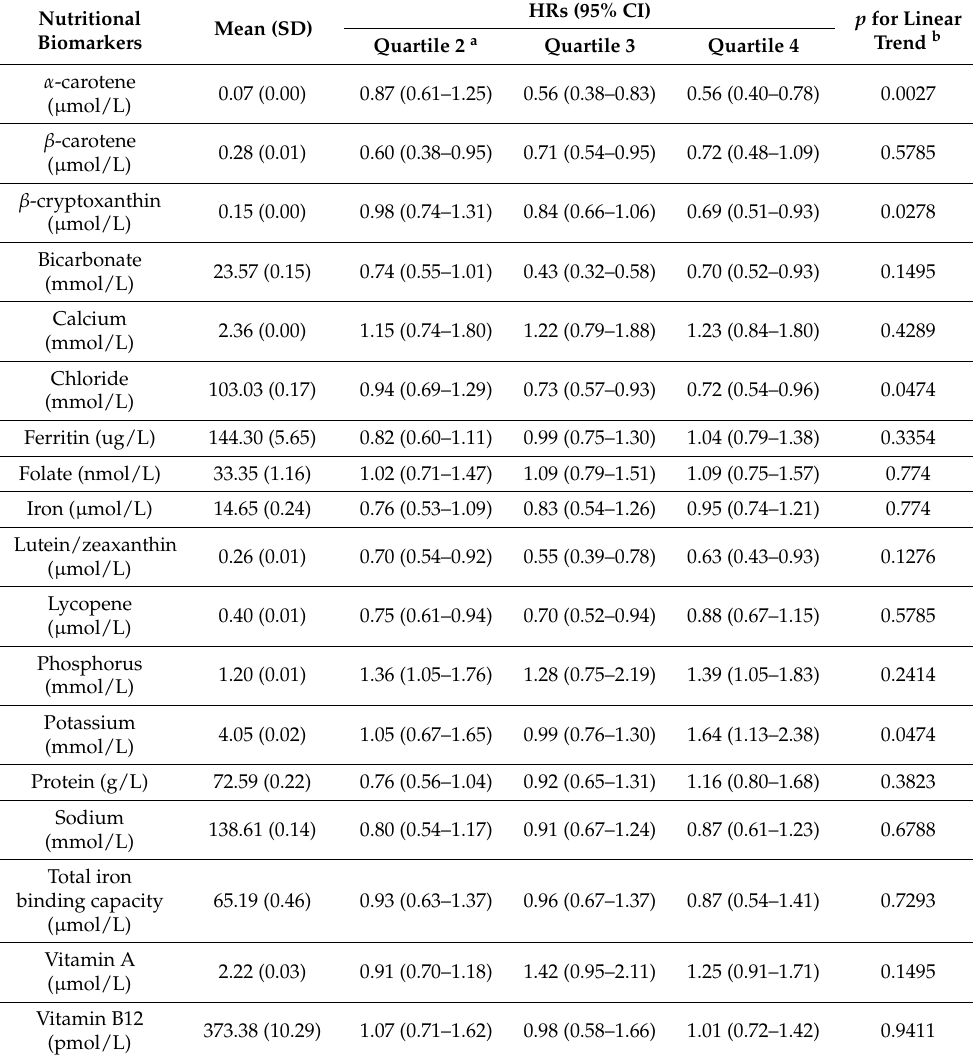
Table 2. Associations between baseline nutritional biomarkers levels and all-cause mortality (HRs and 95%